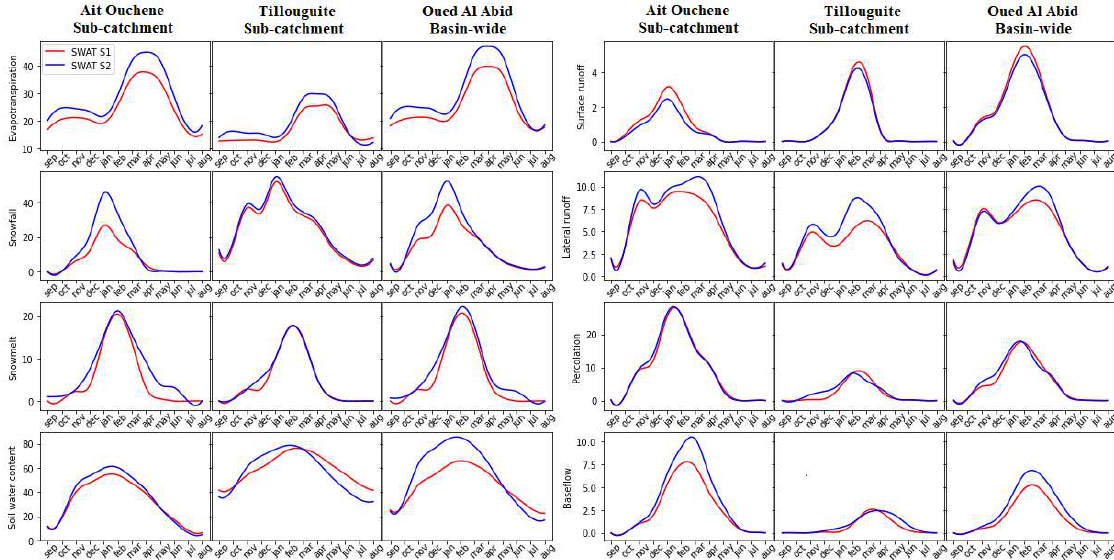
Figure A3. Impact of SWAT configurations on simulated water balance components (mm).